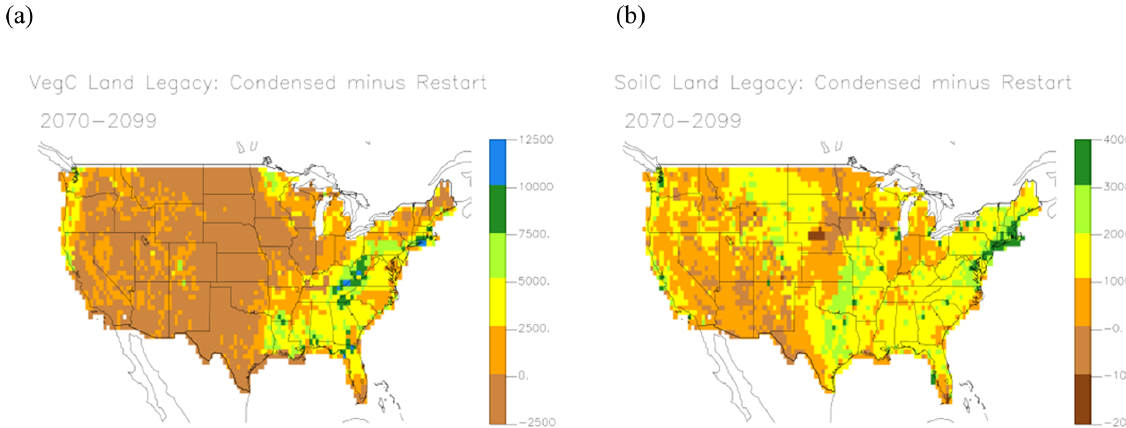
Figure 7. Mapped patterns in (a) vegetation ( − 14350 to 13146gCm − 2 ) and (b) soil carbon ( − 2489 to 9339gCm − 2 ) as differences between the CONDENSED and RESTART